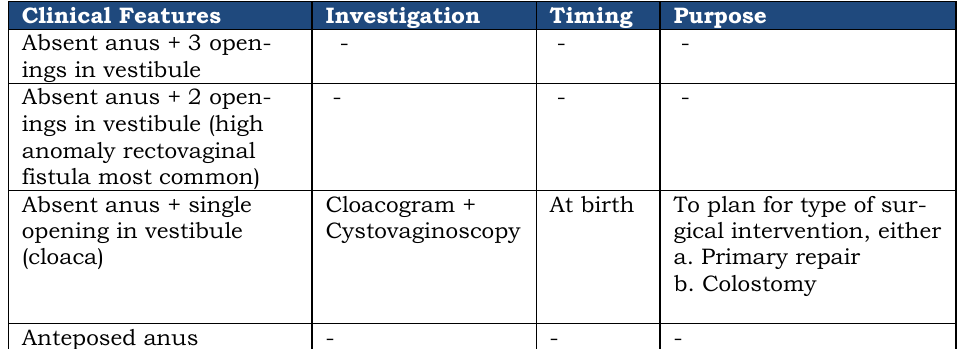
Table 2: Investigations for Anorectal malformations in girls Clinical Features